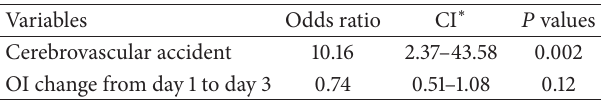
Table 9: Multivariate analysis of predictors of weaning failure in patients with severe acute respiratory